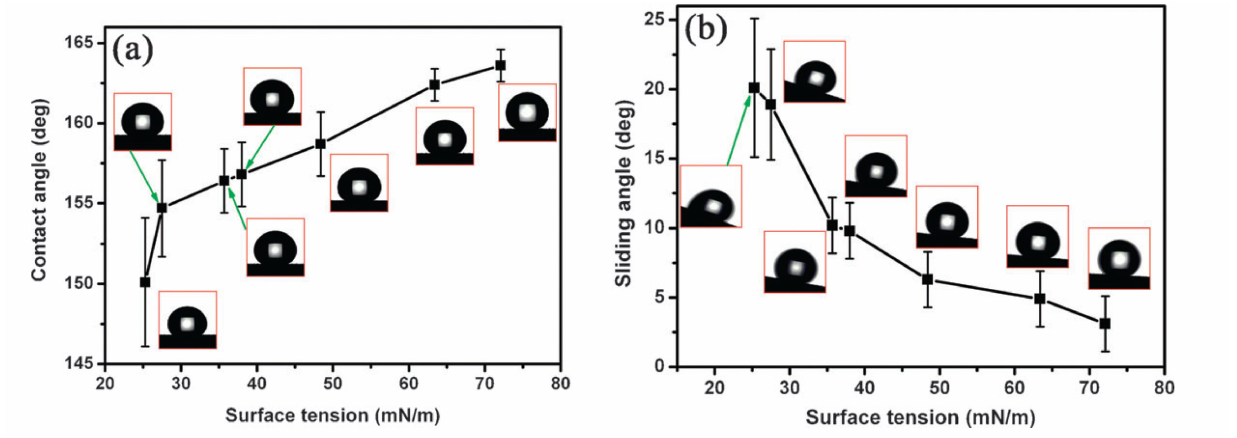
Figure 40. ( a ) Apparent contact angles and ( b ) sliding angles as function of liquid surface tension for superoleophobic coating. Insets show shapes of corresponding liquid droplets. From Yang et al.